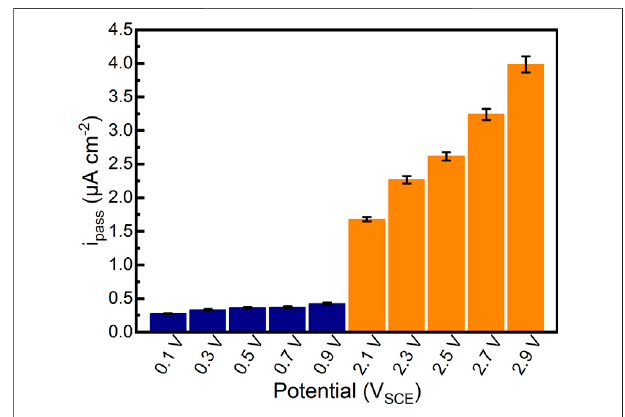
FIGURE5| Quasi-steadypassivationcurrentdensitiesofas-castTi-6Al- 4V in potentiostatic polarization tests under different applied potentials in Hank ’ s solution at 37 ° C.